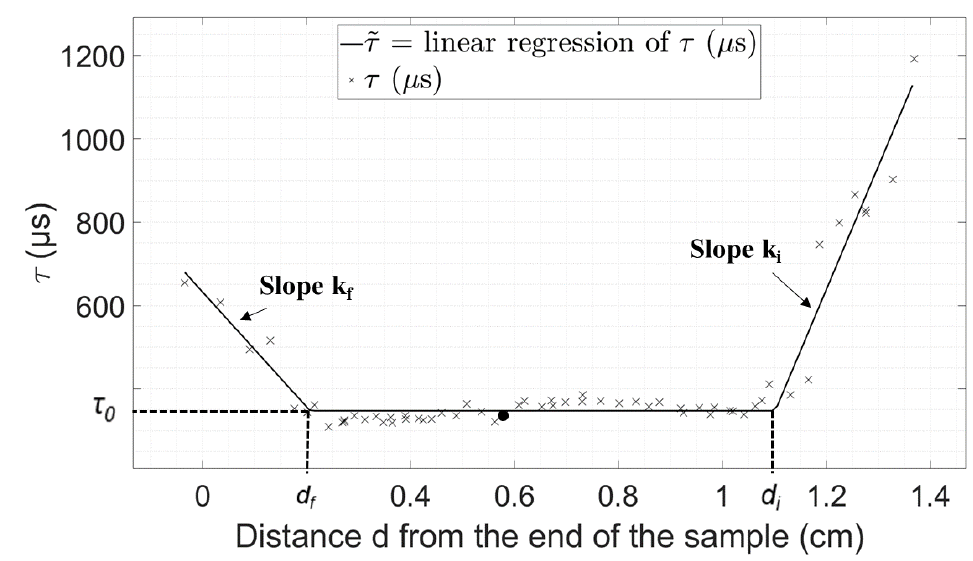
Figure 4. Variation of τ as a function of the distance from the end of the sample (d) obtained with a plywood sample. The linear by part interpolation 𝜏̃ obtained using the minimization procedure is shown by the solid line. The signal indicated by a circle is the signal shown in Figure 2.